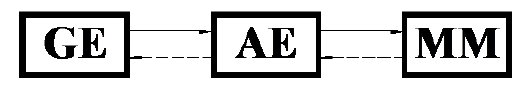
Figure 2. New concept regarding the running of the propulsion sys- tems